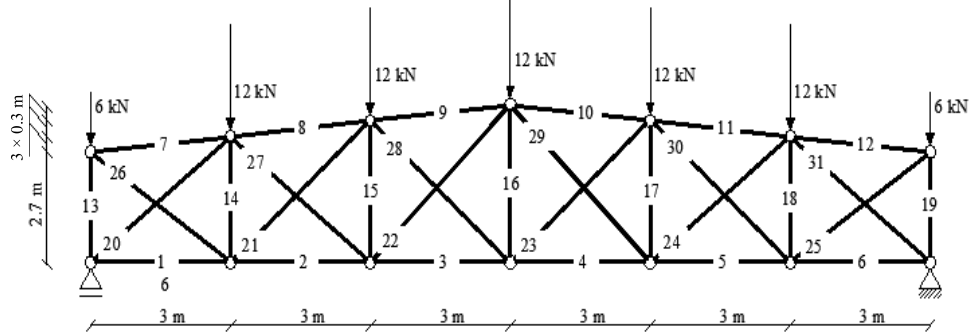
Figure 6. Statically indeterminate structure with six degrees of freedom (Truss 1).